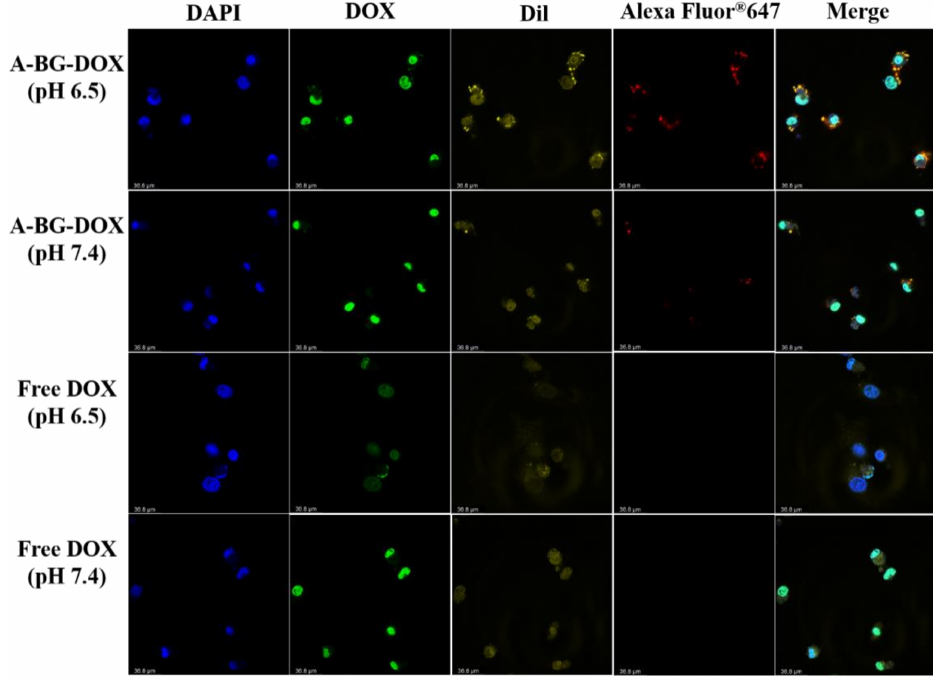
Figure 7. In vitro fluorescence imaging of HepG2 cells after treatment with A-BG-DOX and free DOX in their culture medium at pH 6.5 and 7.4; scar bar is 36.8 µ